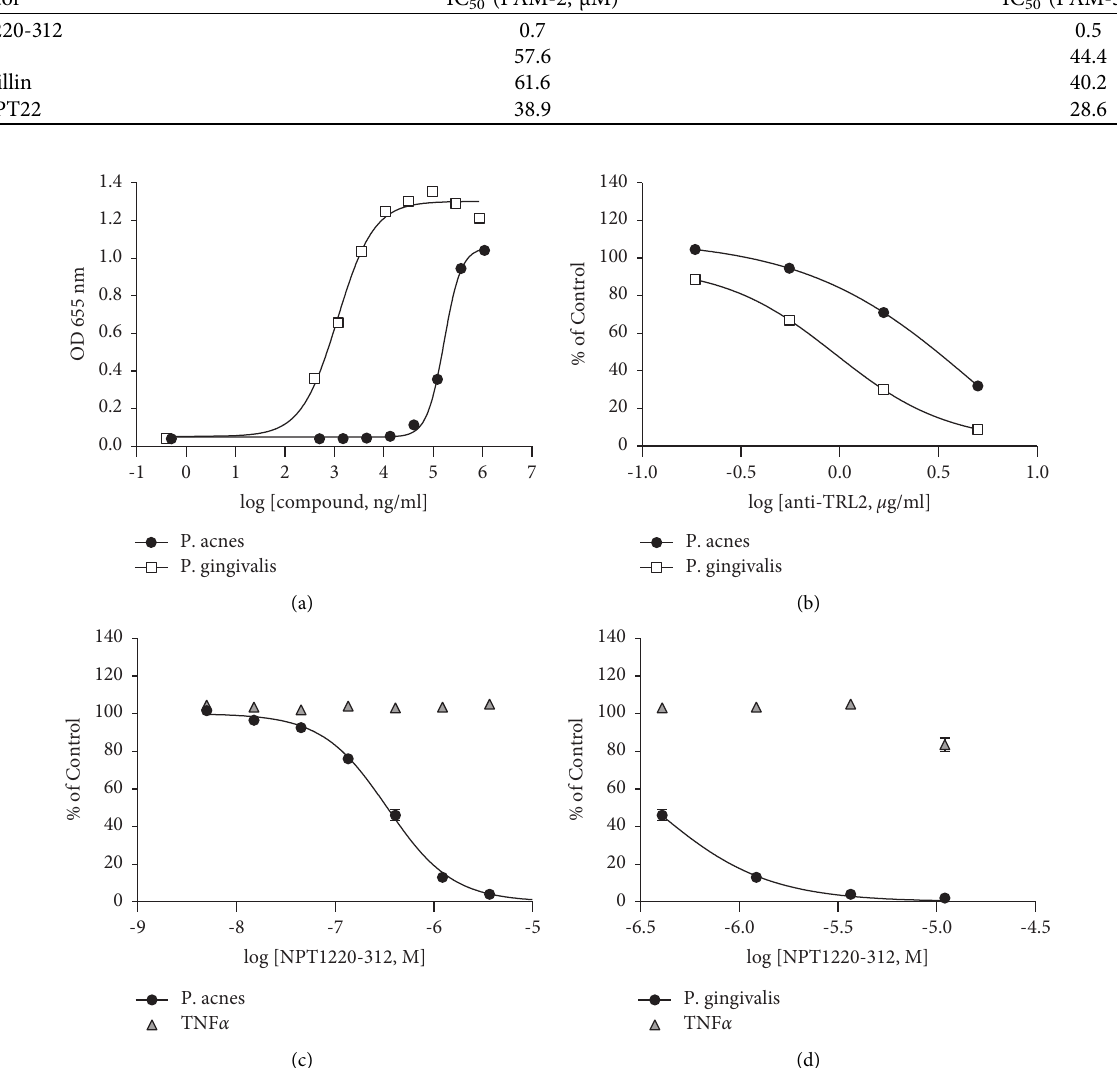
Figure 2: NPT1220-312 blocks TLR2 signaling mediated by natural TLR2 pathogen agonists: (a) concentration-response curves for P. gingivalis or P. acnes in hTLR2 HEK293 cells, (b) blockade of P. acnes or P. gingivalis signaling by an anti-TLR2 specific antibody, (c) blockade of P. acnes -evoked response by NPT1220-312, and (d) blockade of P. gingivalis -evoked response by NPT1220-312 ( ∗ p ≤ 0 . 05 )